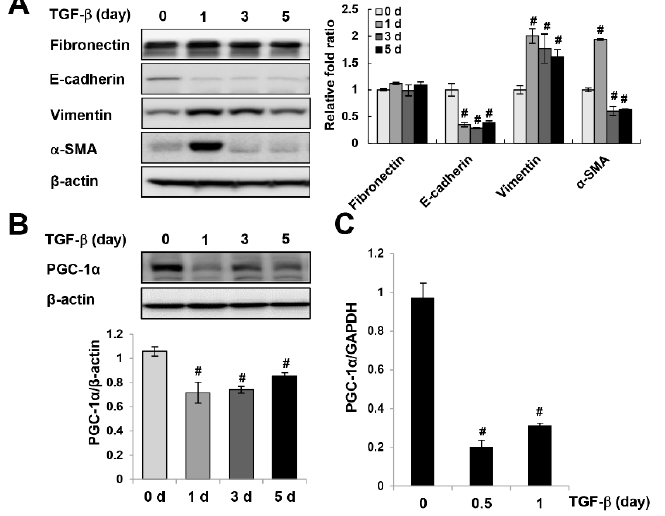
Figure 2. Downregulation of PGC-1 α in TGF- β -treated HK-2 cells. HK-2 cells were exposed to TGF- β . The protein expression of epithelial-mesenchymal transition (EMT) markers (fibronectin, E-cadherin, vimentin, and α -SMA) ( A ) and PGC-1 α ( B ) was analyzed by western blotting. Bar graphs show mean PGC-1 α , fibronectin, E-cadherin, vimentin, and α -SMA/ β -actin expression levels, as measured by densitometry. ( C ) The mRNA expression levels of PGC-1 α in TGF- β -treated HK-2 cells were analyzed by real-time polymerase chain reaction (PCR). # p < 0.05, TGF- β -treated vs. untreated.